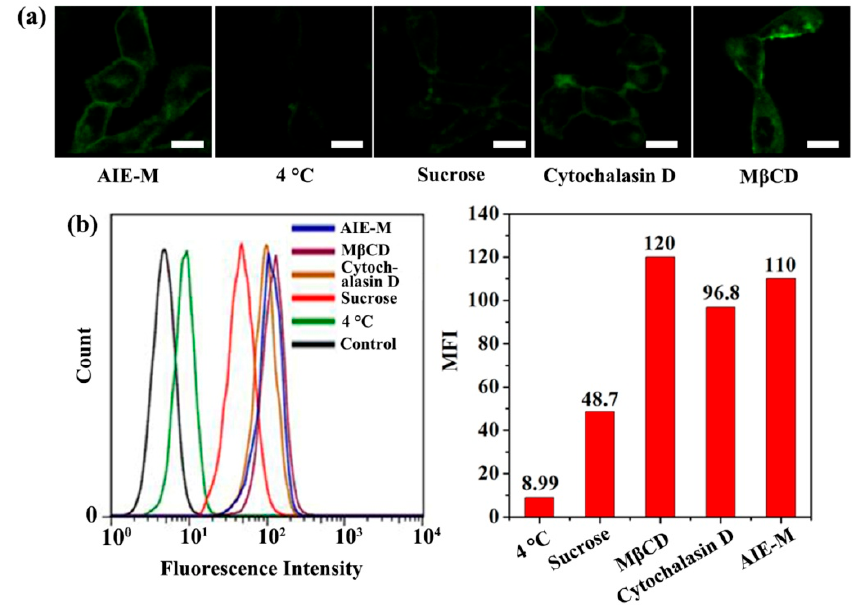
Figure 7. ( a ) CLSM images of HeLa cells after incubation with AIE-M containing different endocytosis inhibitor. The scale bar is 20 μ m; ( b ) Flow cytometry analyses of the effect of endocytosis inhibitors on the uptake of AIE-M by HeLa cells.